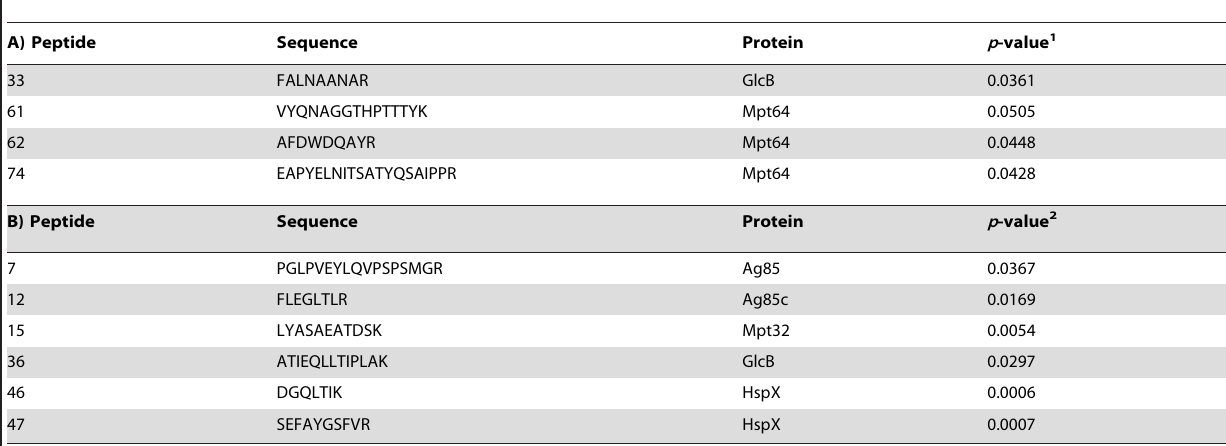
Table 2. Peptides that distinguish (A) PTB or (B) EPTB patients from non-TB patients.